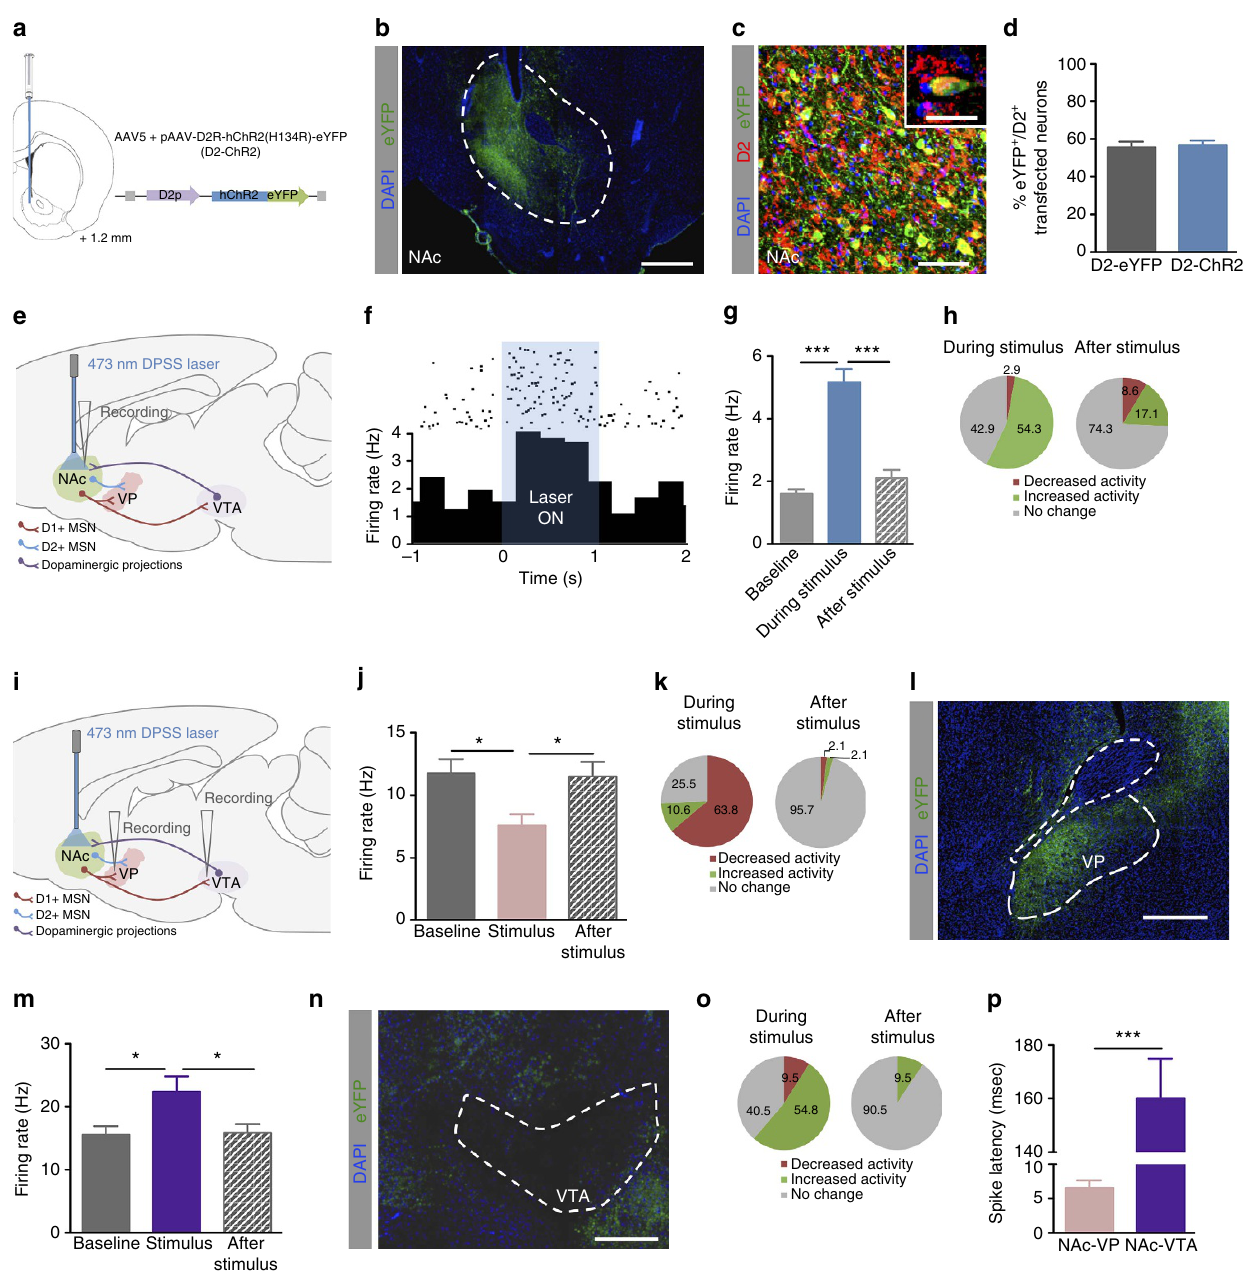
Figure 3 | In loco and downstream electrophysiological recordings. ( a ) Rats received unilateral injection of AAV5-D2-hChR2(H134R)-eYFP in the NAc; number represent distance to bregma. ( b ) Immunofluorescence against YFP showing transfection restricted to the NAc; scale bar: 200 m m; ac: anterior commissure. ( c ) Immunofluorescence showing expression of eYFP in D2 þ neurons; scale bar: 200 m m; inset: 40 m m. ( d ) Around 58% of D2 þ neurons express D2-eYFP or D2-ChR2 ( n ¼ 6). ( e ) Schematic representation of the optogenetic stimulation and in vivo single-cell electrophysiological recording experiments. ( f ) Representative time histogram of NAc electrophysiological single units in response to a 40Hz stimulus. ( g ) Increase in NAc firing rate during optogenetic stimulation (40Hz, 12.5ms pulses for 1s). ( h ) Approximately half of the cells increased firing rate (54%), 42.9% did not respond and 2.5% decreased their activity ( n ¼ 19 cells). ( i ) Schematic representation of the in vivo single-cell electrophysiological recording experiments in downstream regions. ( j ) NAc D2 neuronal activation decreases global VP firing rate ( n ¼ 30 cells). ( k ) During stimulation, 63.8% of VP cells decrease their firing rate,